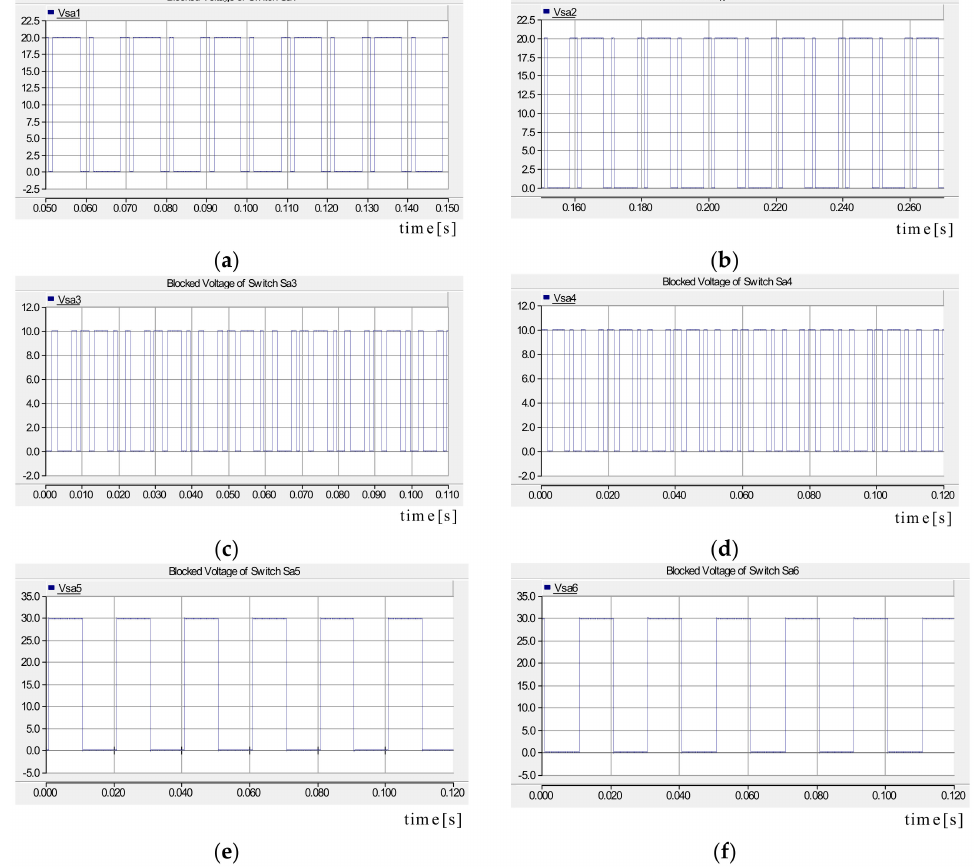
Figure 9. Blocked voltage of switches in Phase A. ( a ) Blocked voltage of switch S a1 ; ( b ) Blocked voltage of switch S a2 ; ( c ) Blocked voltage of switch S a3 ; ( d ) Blocked voltage of switch S a4 ; ( e ) Blocked voltage of switch S a5 ; ( f ) Blocked voltage of switch S a6 ;